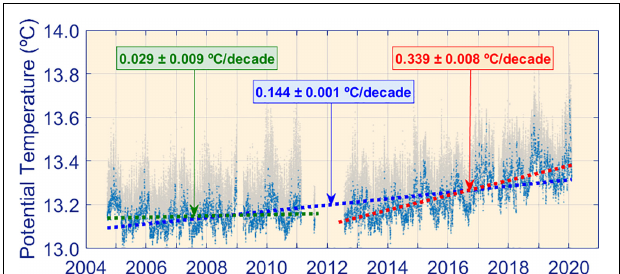
FIGURE 3 | Potential temperature at 14m above seafloor in the monitoring station sampled every 30 min (gray dots) and series of minimum θ in each tidal cycle (light-blue dots). Dashed lines show θ trends for the whole period (blue line), from the beginning of the series to the data-gap in 2011-12 (green line), and from the gap to the end of the series (red